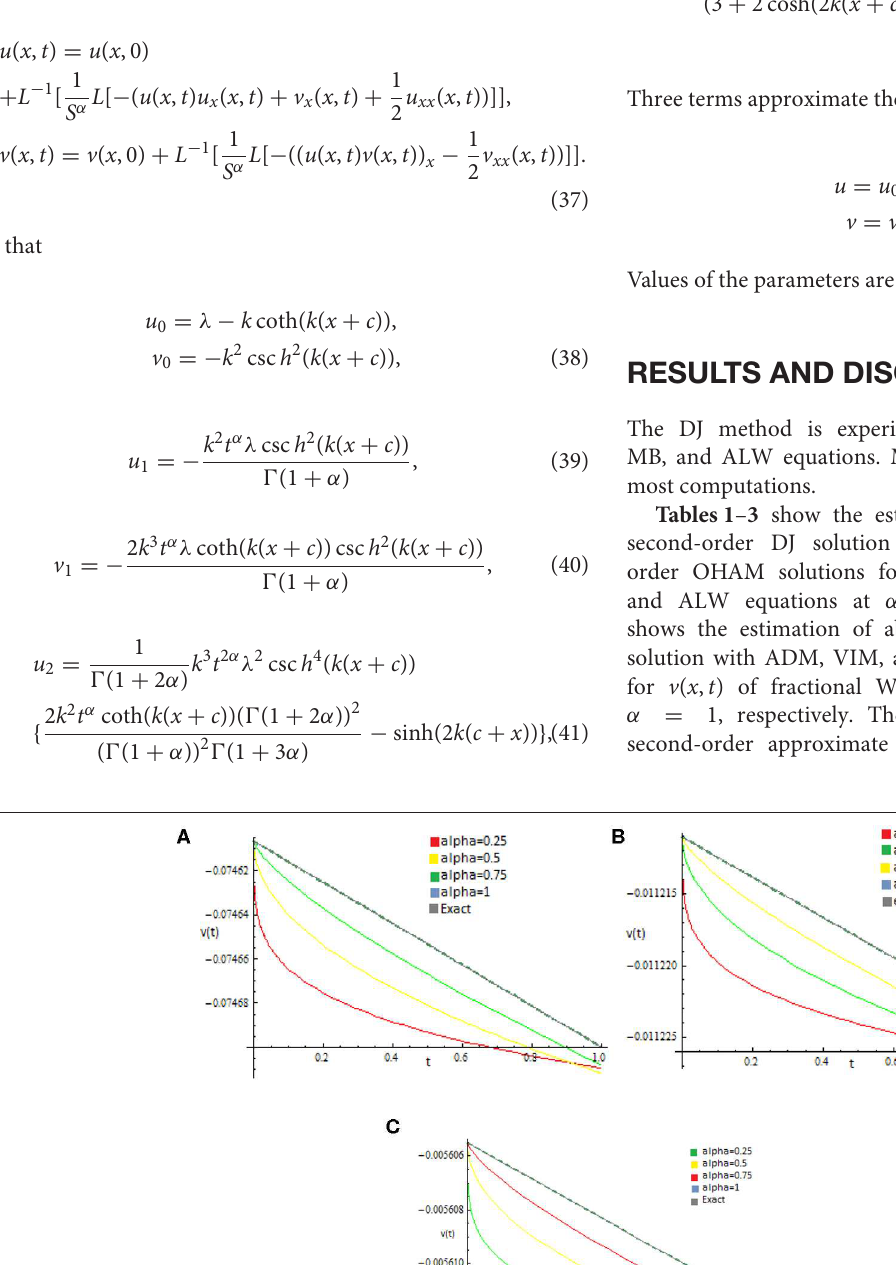
Frontiers in Physics |